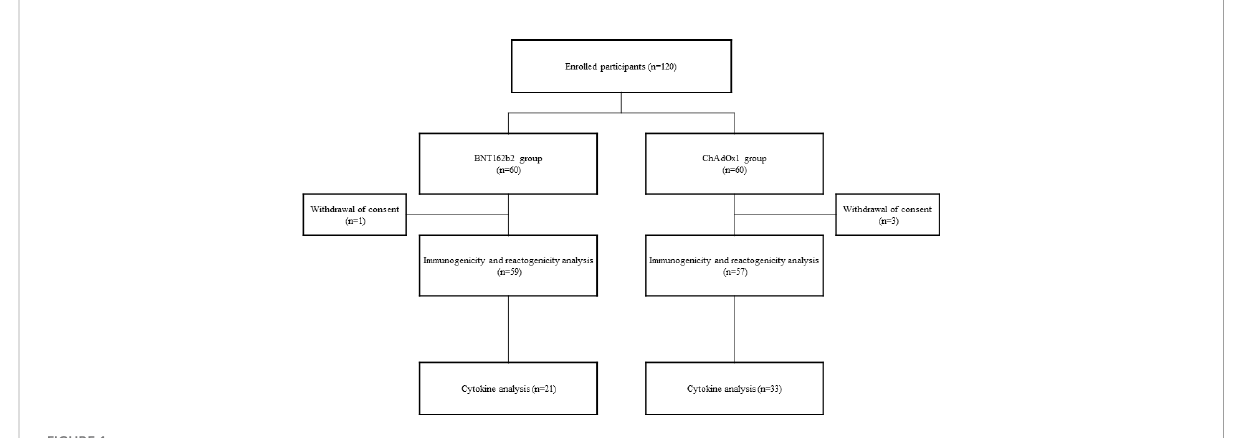
FIGURE 1 Diagram showing the study fl